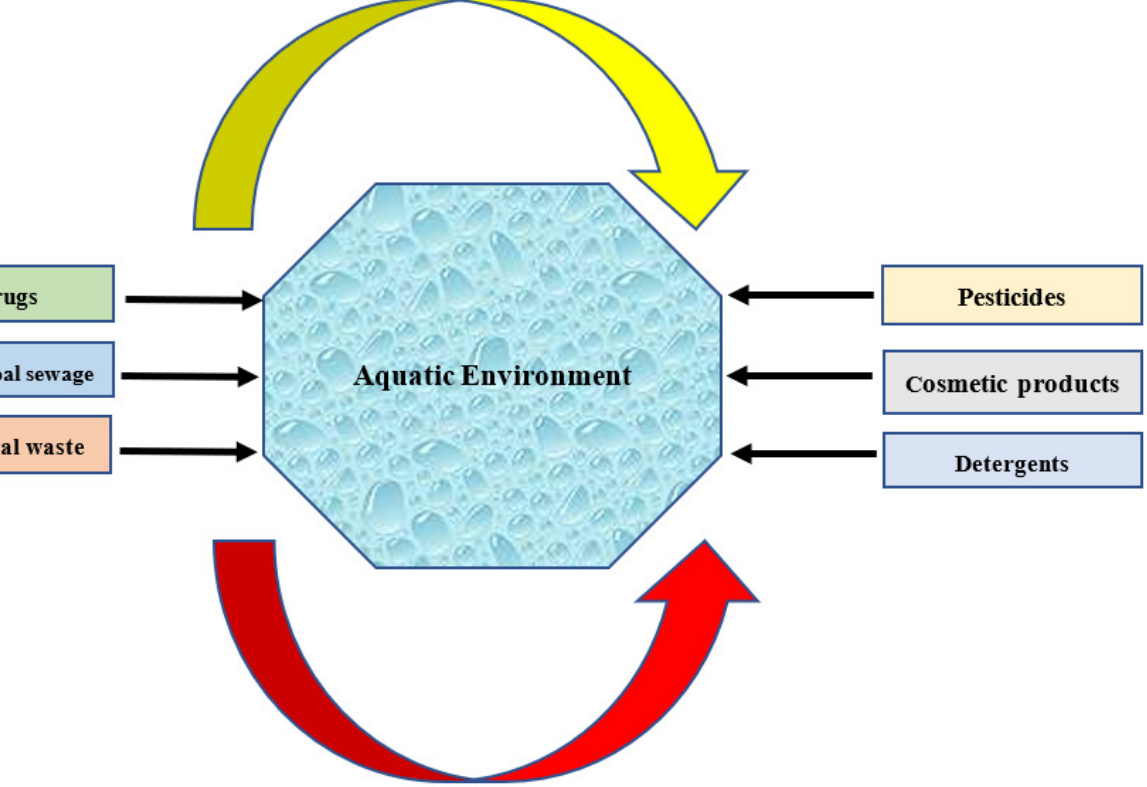
Figure 1. Principal sources of micro ‐ contaminants in aquatic environments.